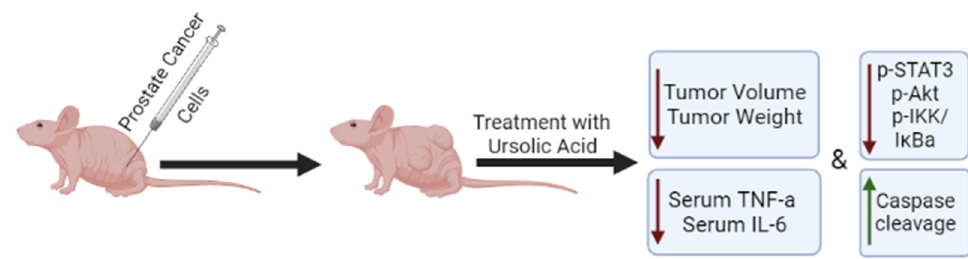
Figure 3. E ff ects of ursolic acid treatment on prostate cancer in vivo. Mice xenografted with prostate cancer cells and treated with ursolic acid, had reduced tumor volume and weight compared to untreated animals. The overall survival was also increased in UA-treated animals in one study. Ursolic acid treatment reduced the serum levels of TNF- α and IL-6 and the phosphorylation/activation of STAT3, AKT, and IKK α / β in tumor tissues. ↑ = Increased; ↓ =